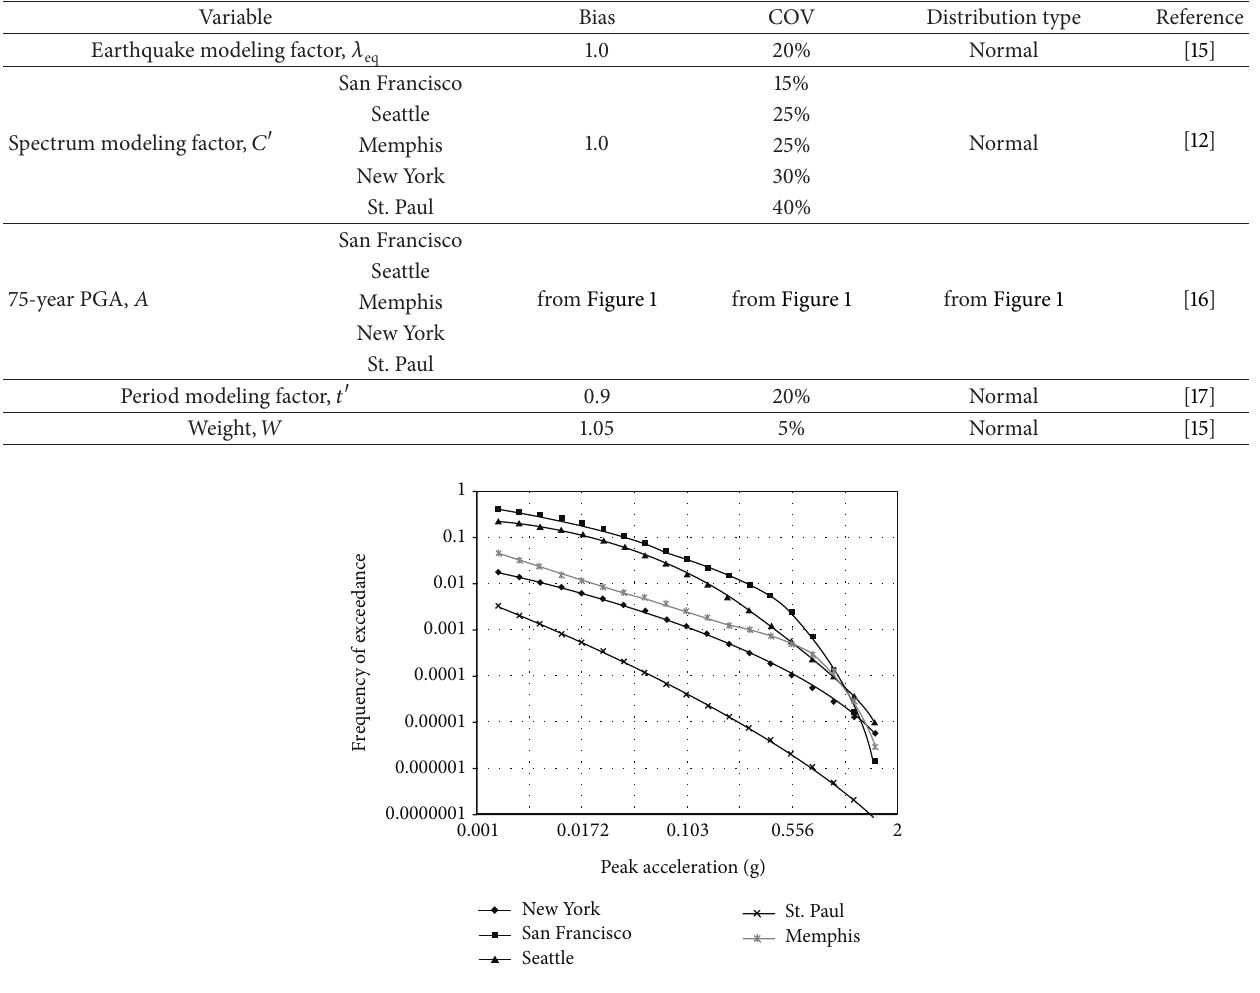
Figure 1: Annual probability of exceedance curves for PGA